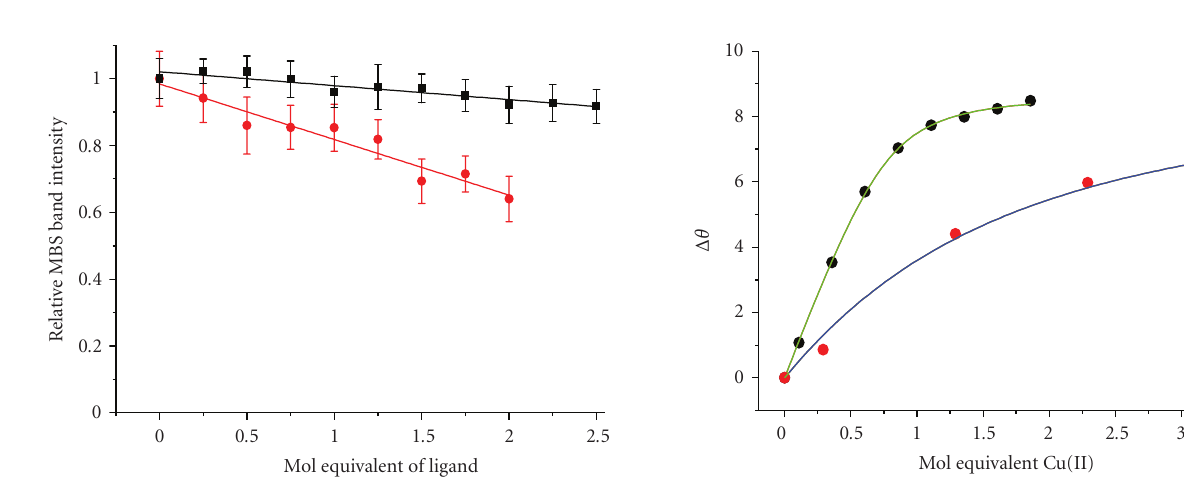
Figure 8: Comparison of titration curves for Cu(II) binding at MBS obtained in the presence of 1mol equivalents of Ibu (experimental points, , and fits to the K app formula, ) and War (experimental points, , and fits to the K app formula,